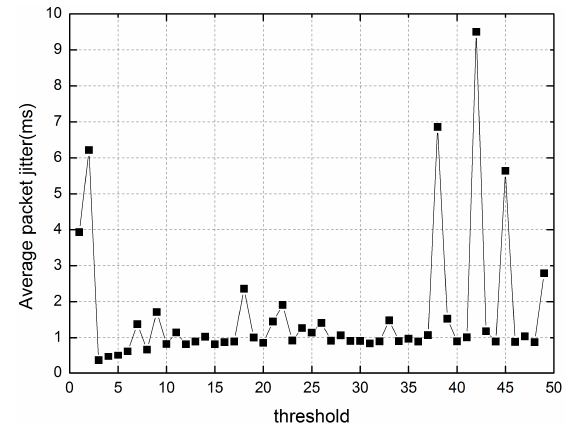
Figure 5. Average packet jitter versus